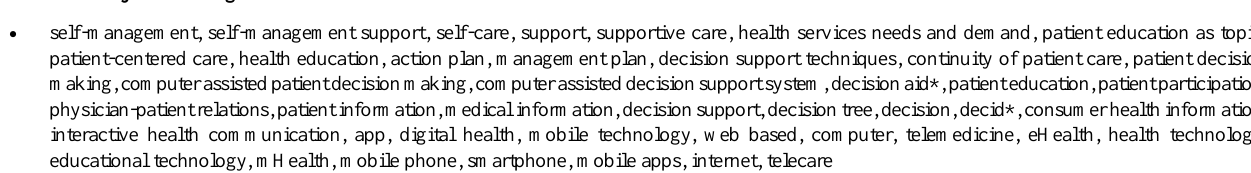
Figure 1 outlines the search process. A total of 6047 references were identified through the search. Screening titles, abstracts, and full texts yielded 19 eligible